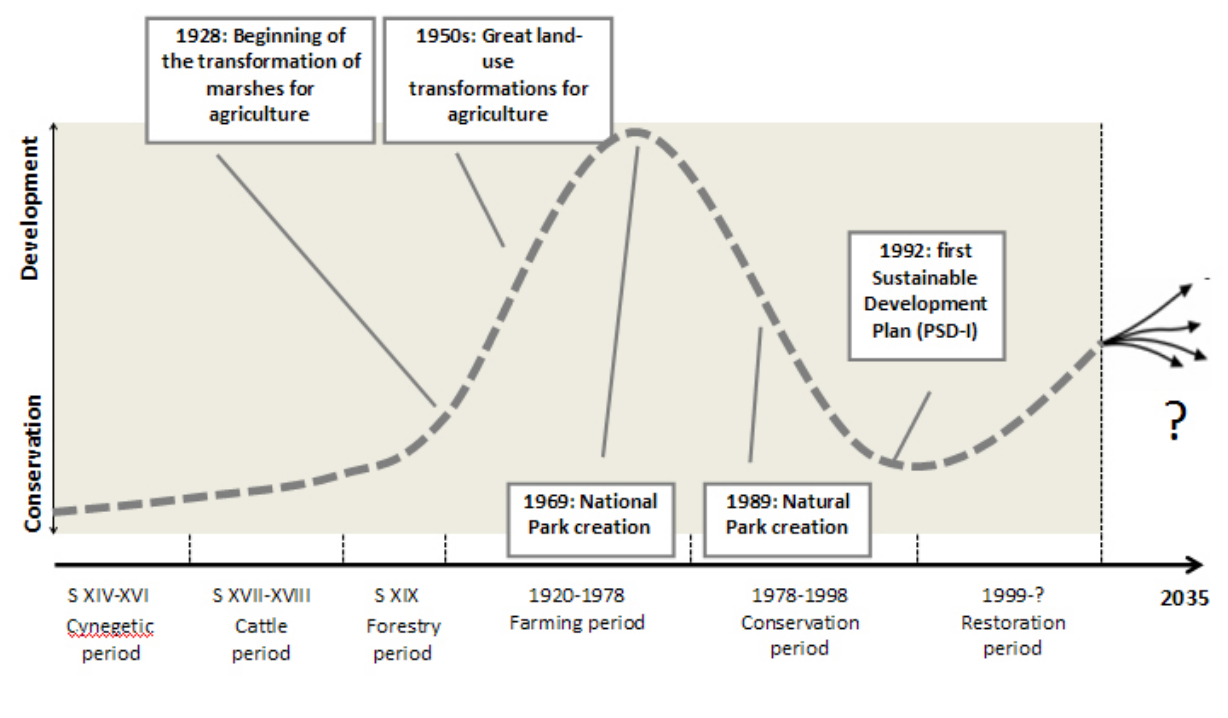
Fig. 2 . Schematic illustration of the evolution of the Doñana social-ecological system attending to the conservation vs. development conflict. The x-axis symbolizes time, where the main stages of the Doñana social-ecological system are reflected. The main events regarding the conservation vs. development conflict are represented in boxes. Adapted from Enfors et al.